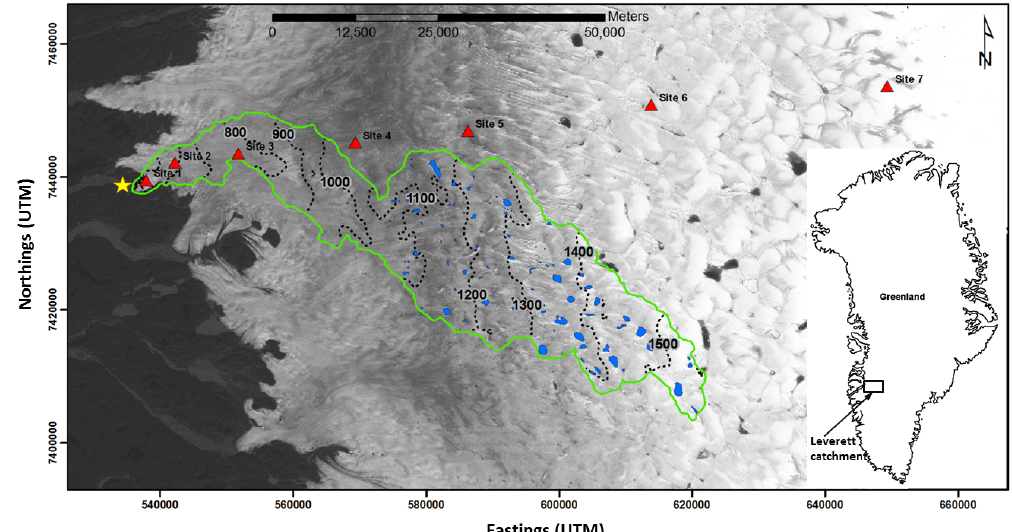
Figure 1. Leverett Glacier surface hydrological catchment (outlined in green). Contours show ice surface elevation (ma.s.l.); locations of meteorological data collection are depicted by red triangles; the location of proglacial discharge measurements is represented by the yellow star; and supraglacial lakes are highlighted in blue. The background image is from Landsat 7, band 2, captured on 5 August 2005.